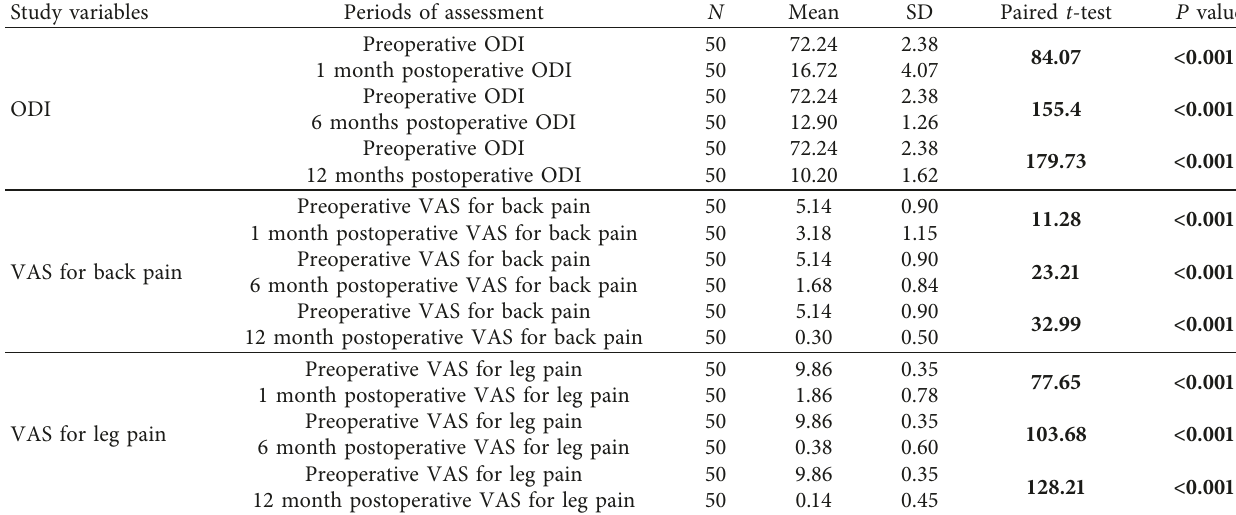
Table 5: The mean differences of ODI, VAS for back pain, and VAS for leg pain between preoperative and postoperative assessments three times. Study variables